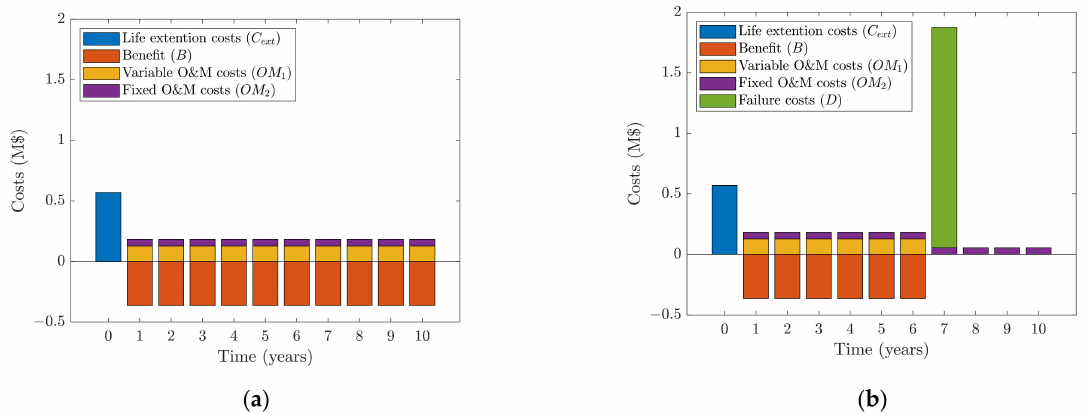
Figure 2. Illustration of how the benefits and costs are distributed in time in the extended life: ( a ) when there is no failure in the extended life; ( b ) when there is a failure in year